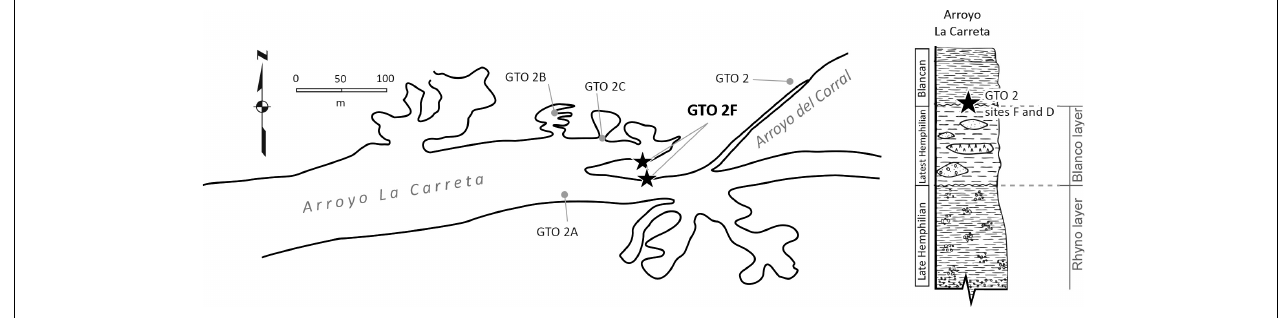
FIGURE 4 | Map of Arroyo La Carreta, where the fossil localities of Rancho El Ocote are located. Note that the GTO 2 site D and F are on top of Blanco layer, the stratigraphic column show the sites in the Blanco layer (Latest